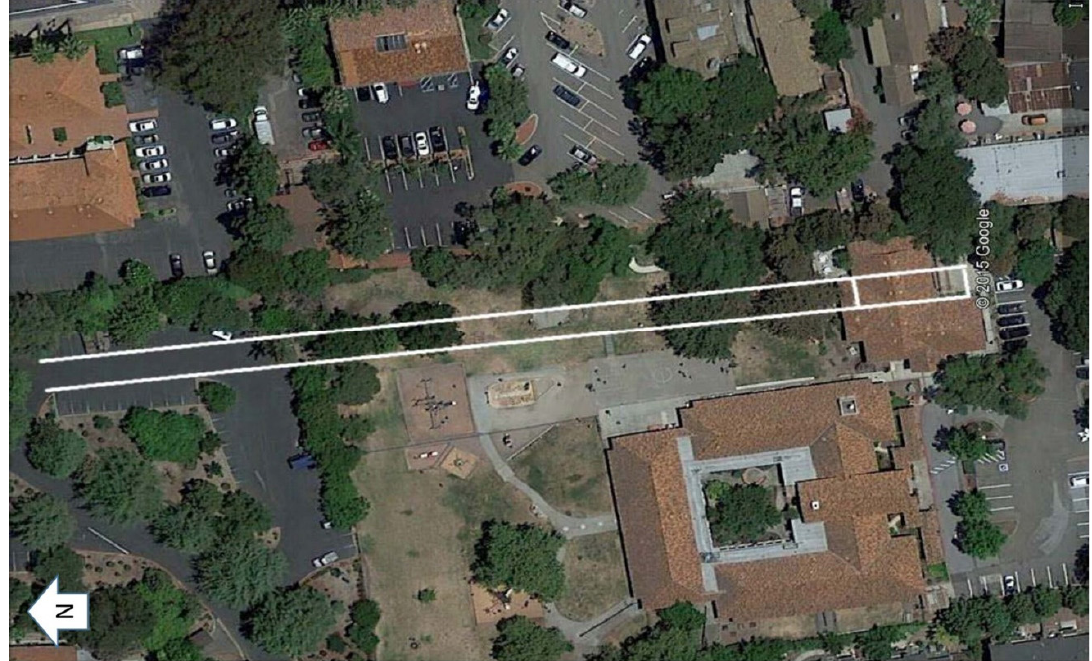
Figure 14. Possible projection of Native American adobe housing from 2001 excavations.